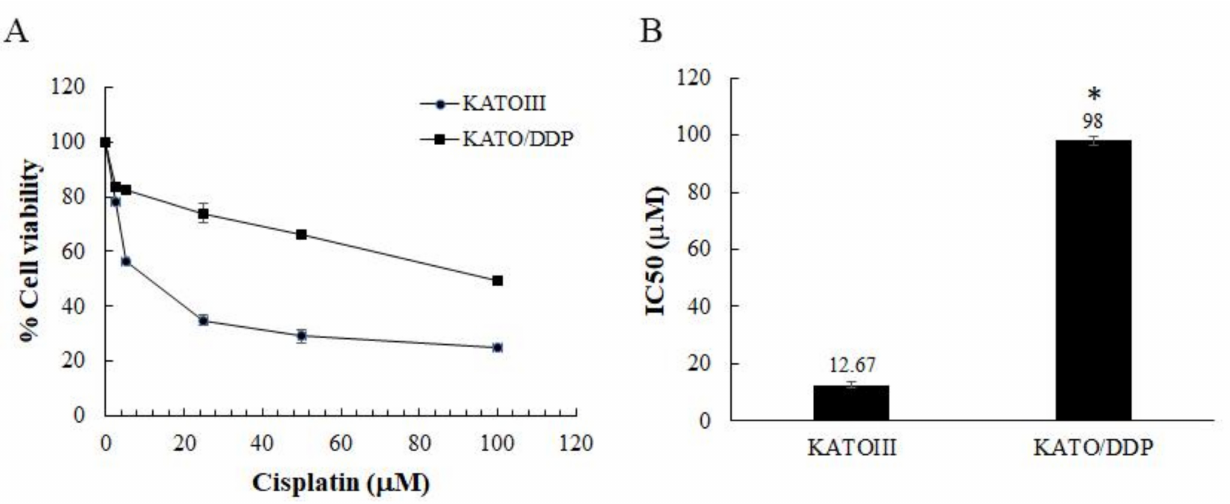
Figure 1. Response of parental drug-sensitive KATOIII and drug-resistant KATO/DDP cells to cisplatin cytotoxicity. KATOIII and KATO/DDP cells were treated with different concentrations of cisplatin (0–100 µ M) for 48 h, and cell viability was assessed by trypan blue cell exclusion assay. ( A ) Cell viability of KATOIII and KATO/DDP. ( B ) IC 50 value of cisplatin in KATOIII and KATO/DDP cell line. The data are presented as means; * represents p < 0.05 when compared to